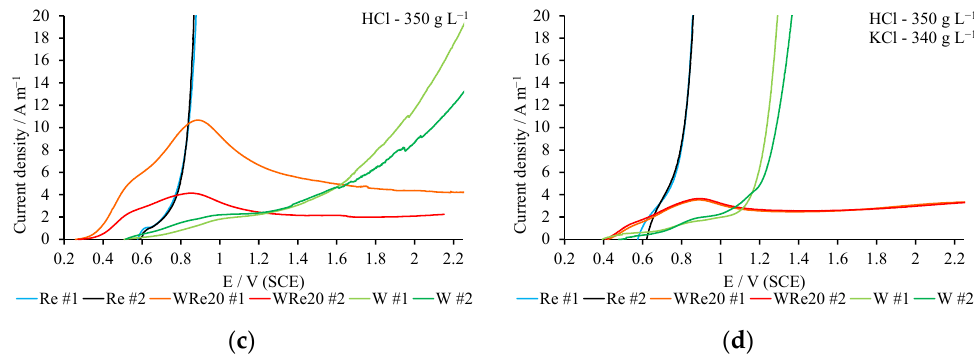
Figure 1. The data of linear voltammetry in different solutions: ( a ) Solution 1; ( b ) Solution 2; ( c ) Solution 3; ( d ) Solution 4.